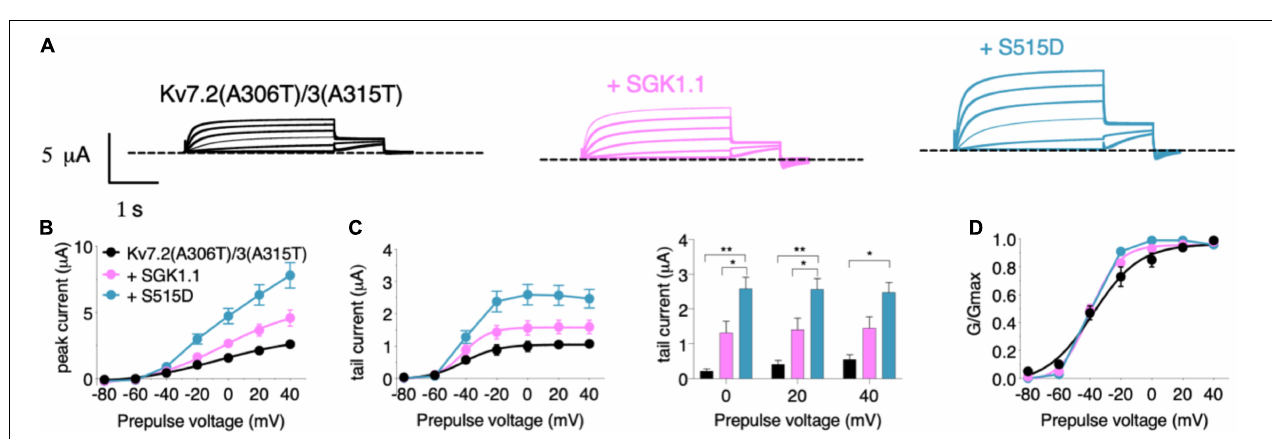
FIGURE 4 | Constitutively active form of SGK1.1 (S515D) upregulates Kv7.2 epilepsy mutation A306T in heteromeric assembly with Kv7.3 (A315T). (A) Currents elicited in Xenopus oocytes after coinjection of cDNAs from Kv7.2 (A306T)/3(A315T) channel alone (first panel) or in combination with wild-type (second panel) or constitutively active (third panel) SGK1.1. (B) Peak current/voltage relationship. (C) Tail current (left) and tail currents measured at –30 mV after 0, + 20 or + 40 mV depolarizing pulses for the indicated construct combinations (right). Values represent mean ± SEM (Two-way ANOVA Tukey’s correction for multiple comparisons; * p < 0.05; ** p < 0.01). (D) Normalized conductance. Legends are indicated on graph (B)